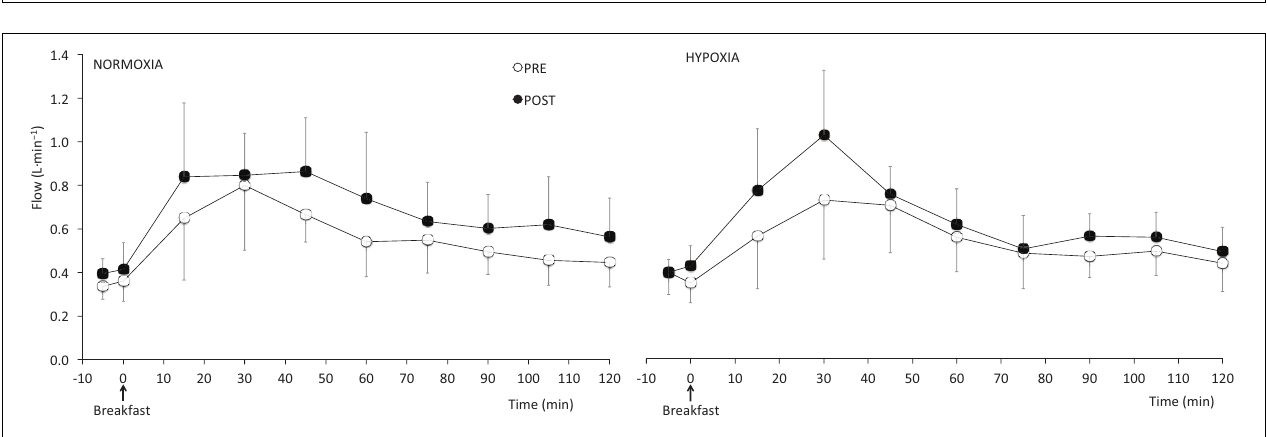
FIGURE 4 | Postprandial blood flow of the superior mesenteric artery before (PRE) and at the end (POST) of the 10-day normoxic (NORMOXIA) and hypoxic (HYPOXIA) confinements. Values are mean ± SEM, n =